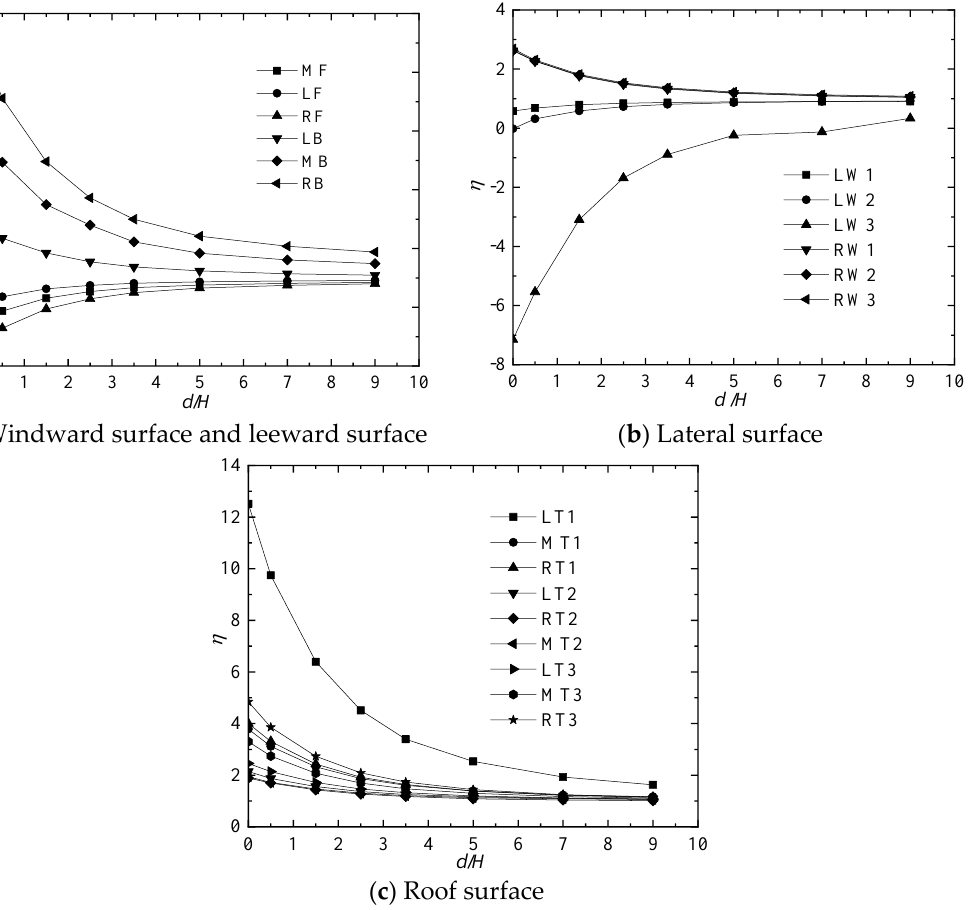
Figure 16. Relative value of wind pressure coefficient in valleys to that in plain areas considering 45° greenhouse azimuth.